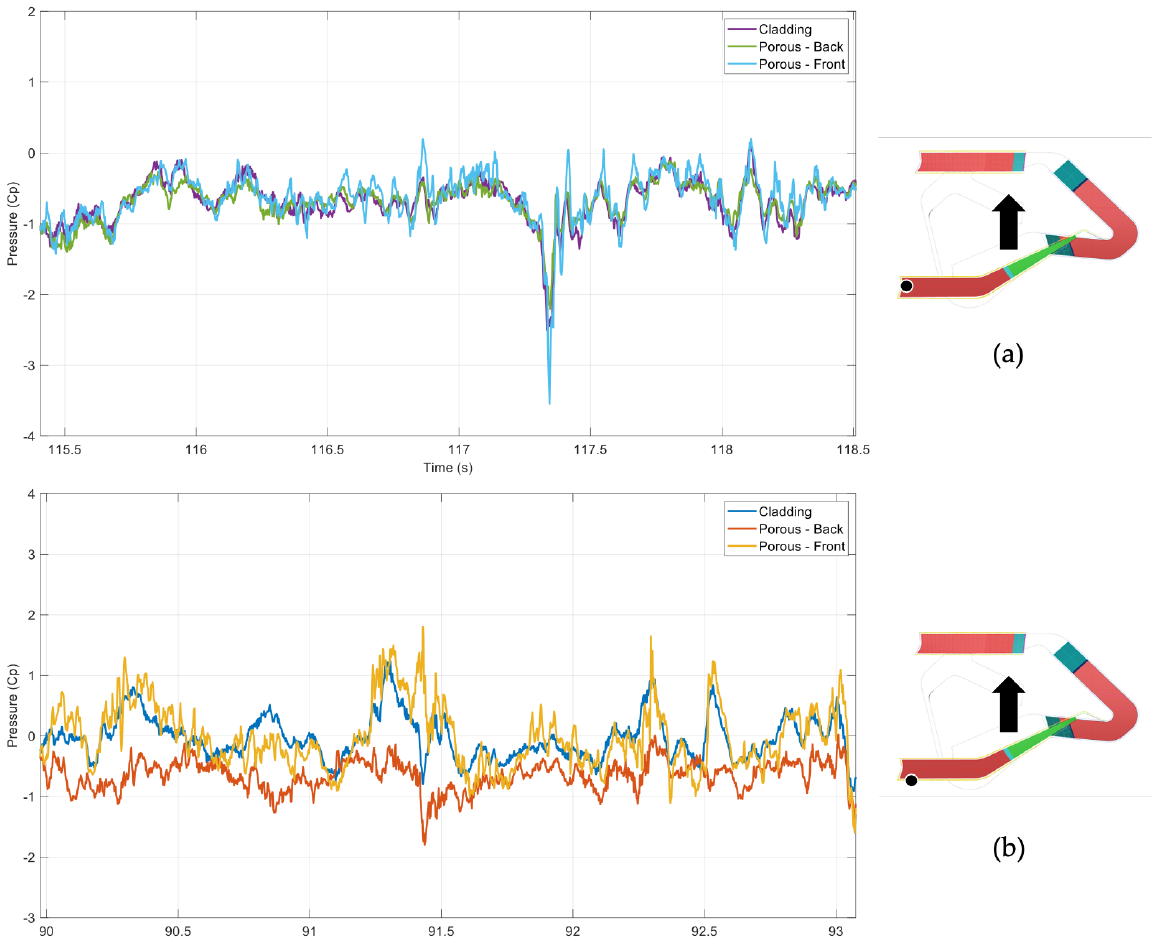
Figure 14. Time domain comparison between the glass façade and the porous skin pressure signals: the plots on the left show a snapshot of the signals, while those on the right show the location of the pressure taps along with the incoming flow direction. ( a ) Downwind side. ( b ) Upwind